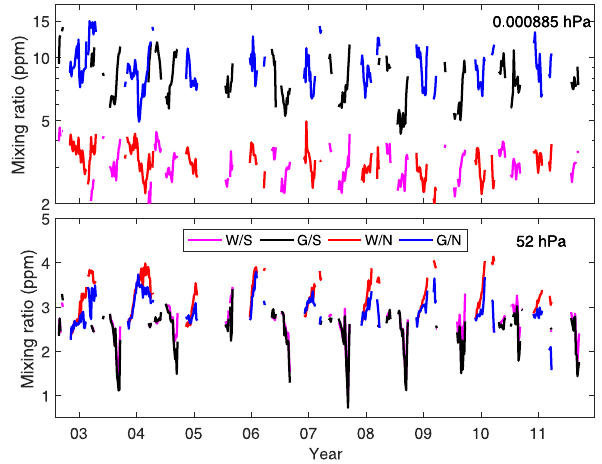
Figure 4. WACCM and GOMOS ozone mixing ratio correlation over 2002–2011. The correlation is calculated from 5-day time se- ries. Latitudes are from − 90 to 90 ◦ with 10 ◦ resolution. A crossed cell marks a point where the correlation does not deviate from zero in a statistically significant way. A cell with a dot marks a point where there are no collocated profiles.